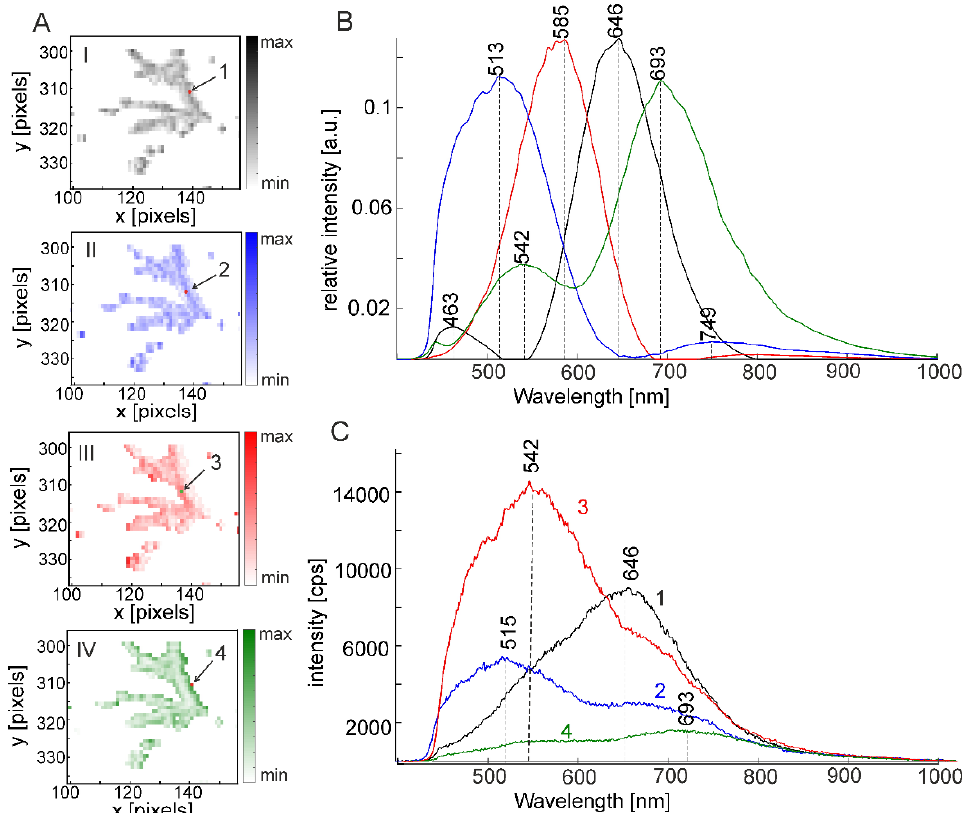
Figure 3. ( A ) NMF maps corresponding to the four pure components of the magnified region of the dark field image of silver nanoparticles presented in Figure 2. The NMF maps visualize the relative contribution of each of the four pure components. Therefore, each pixel has an intensity value between 0 and 1, and the sum of all contributions to the same pixel in each map equals 1. ( B ) The four NMF components. The colors of the component spectra correspond to those of the NMF maps in ( A ). ( C ) Extracted spectra from the marked spots in ( A ).